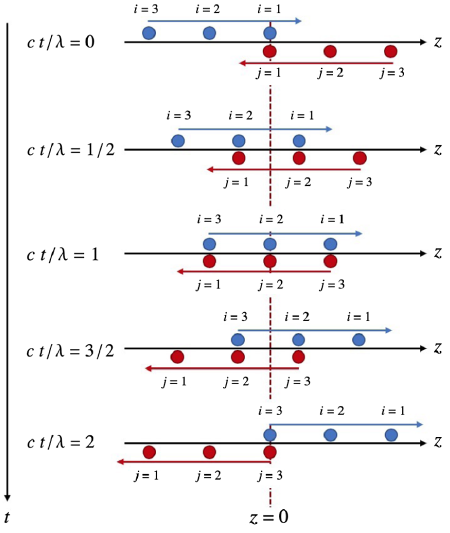
FIG. 2. Schematic of the e þ e − collision process with M ¼ 3 microbunches per train. At t ¼ 0 the first microbunches of each train collide. For an arbitrary M , the full duration of the interactions is Δ t ¼ ð M − 1 Þ λ =c with a total of M 2 microbunch